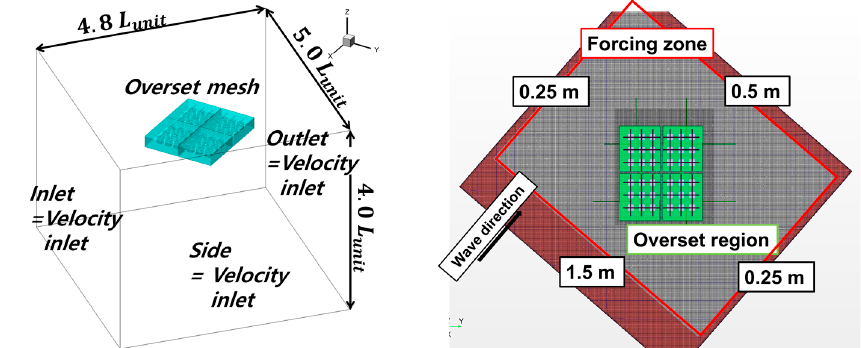
Figure 8. Computation domain and boundary conditions for oblique sea conditions.